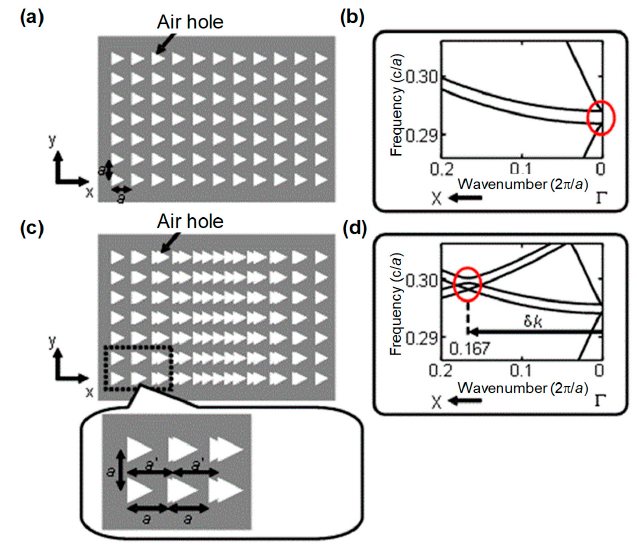
Figure 6. Schematic of photonic-crystal structures and photonic-band structures for obtaining oblique-angle emission. ( a , b ) Square-lattice photonic crystal. ( c , d ) Composite (square- and rectangular-lattice) photonic crystal. Reprinted by permission from Springer Nature, Nature Photonics [10], 2010.